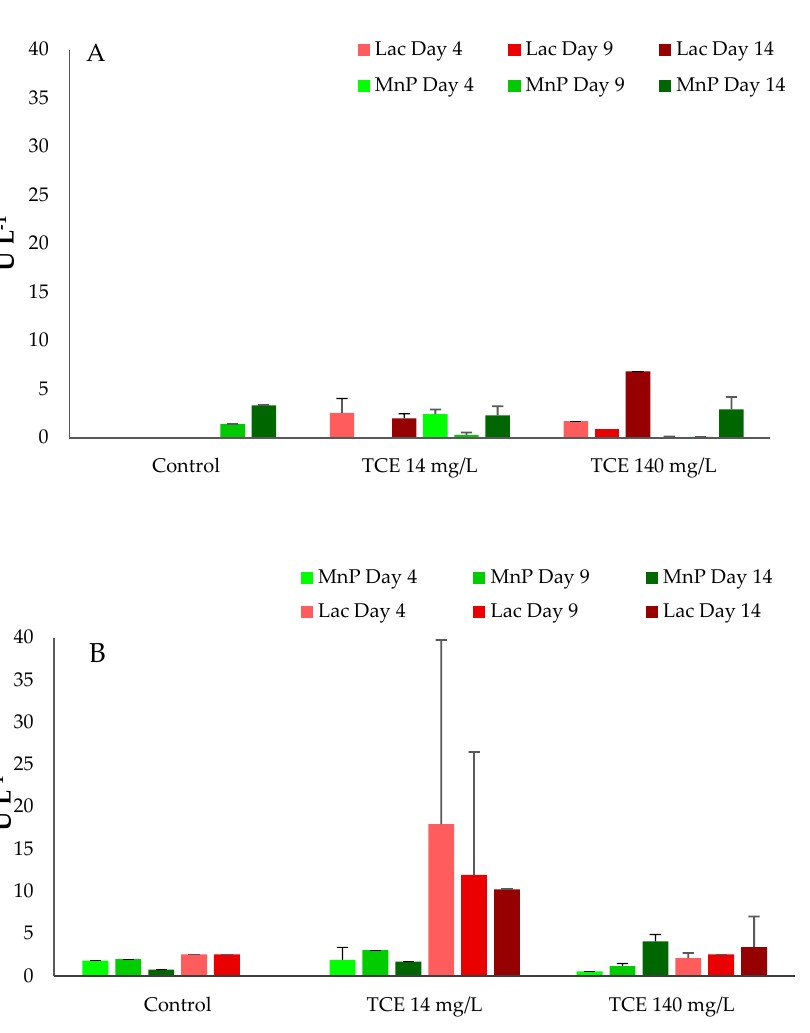
Figure 3. Laccase (Lac) and MnP activity of P. ostreatus ( A ) and P. eryngii ( B ) in the absence and presence (14 mg kg -1 and 140 mg kg -1 ) of TCE for 14 days in malt extract liquid media. Error bars represent the standard deviation (n = 3).